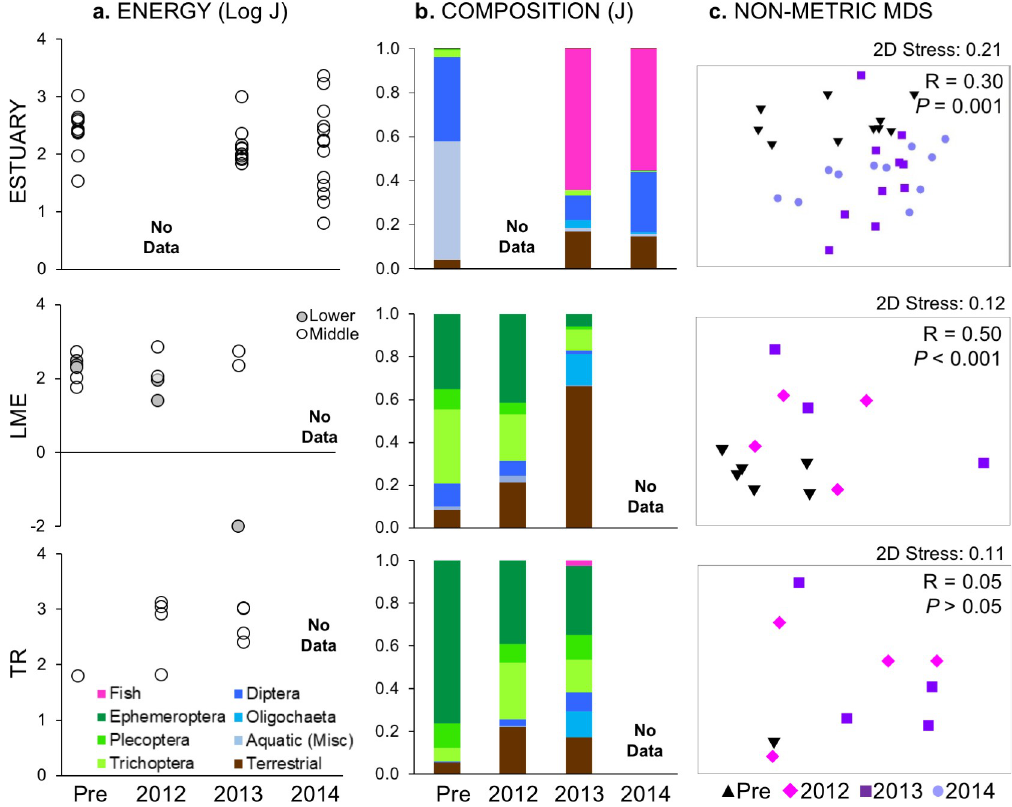
Fig 7. Spring fish diet by section and sample year. Data are plotted as (a) mean total prey energy per fish by site, (b) relative composition by major taxonomic groups (section means), and (c) nMDS, with global sample statistic and significance for one- way ANOSIM by year; note that ordinations with 2D stress values > 0.2 may not adequately represent data structure [36]. All data are in J. For panel a, different letters indicate significant year differences ( P < 0.05) within a section. Note that y-axis range varies by section, and that collection methods varied between estuary and river